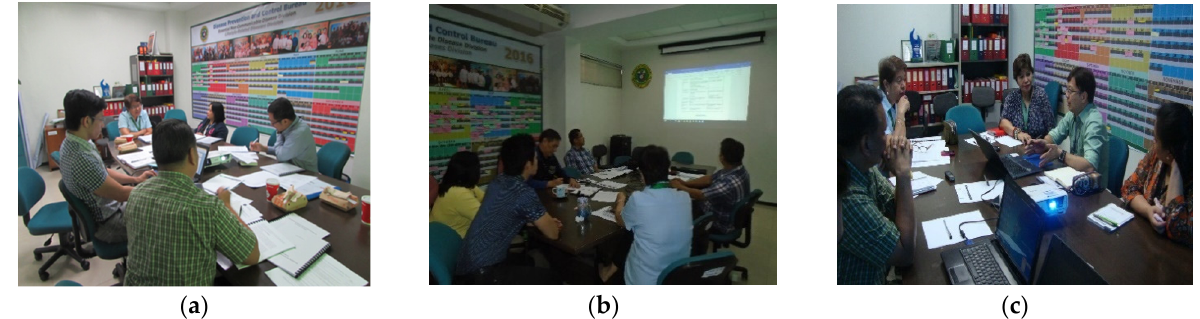
Figure 1. Core group meetings among the representatives of the University of the Philippines College of Public Health Foundation, Inc. [UP-CPHFI], Department of Health (DOH), and World Health Organization (WHO): ( a ) Initial planning on how to conduct the multisector action plan development; ( b ) discussion of the agenda and activities for the multi action plan development; ( c ) discussion on the proceedings of the multisector action plan development.